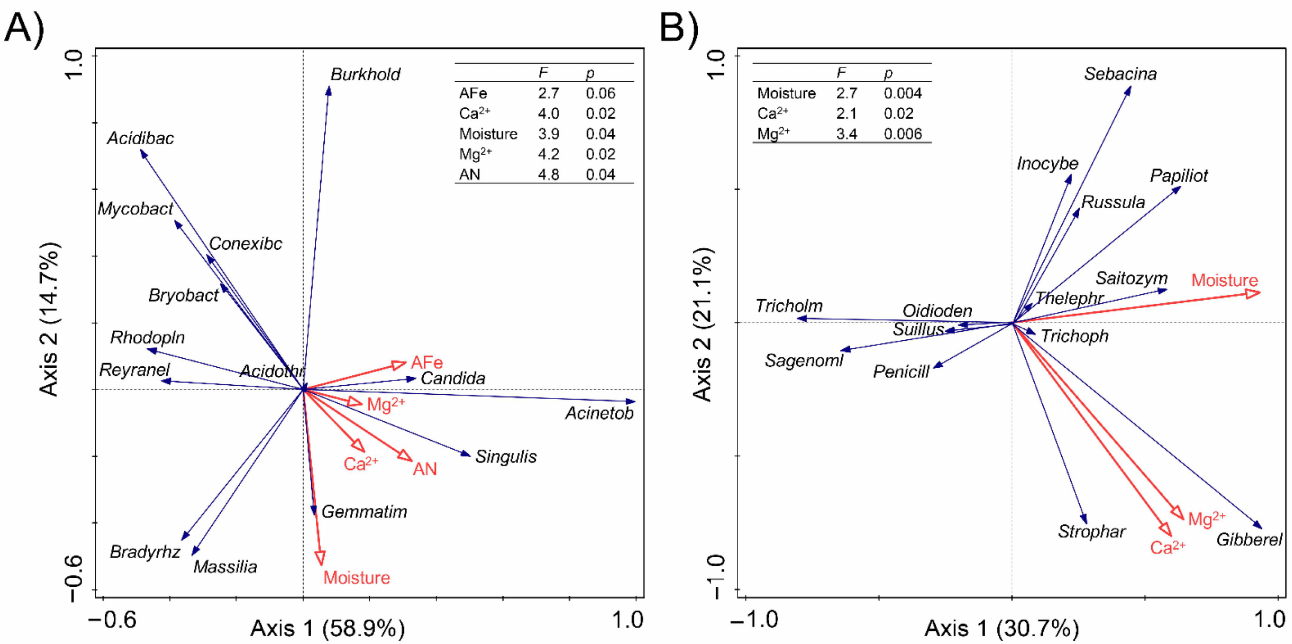
Figure 8. Relationships of the most influential soil properties and bacterial ( A ) and fungal ( B ) genera in soils with Stropharia rugosoannulata cultivation. Length of arrows represents the association strength of the respective soil properties with the microbial genera. Angle between vectors indicates the degree of their relationship (smaller angle means high correlation). Values on the axes illustrate the percentage explained by redundancy analysis (RDA) or canonical correspondence analysis (CCA), based on the gradient length by detrended correspondence analysis ordination axis. To reduce the large number of explanatory factors (soil properties, enzyme activities and microbial abundance) and avoid overfitting the RDA/CCA, the interactive selection of top three to five most influential variables was used. Details in CCA/RDA selection are explained in Section 2.5. Abbreviations used in the figure were described in Tables 1 and